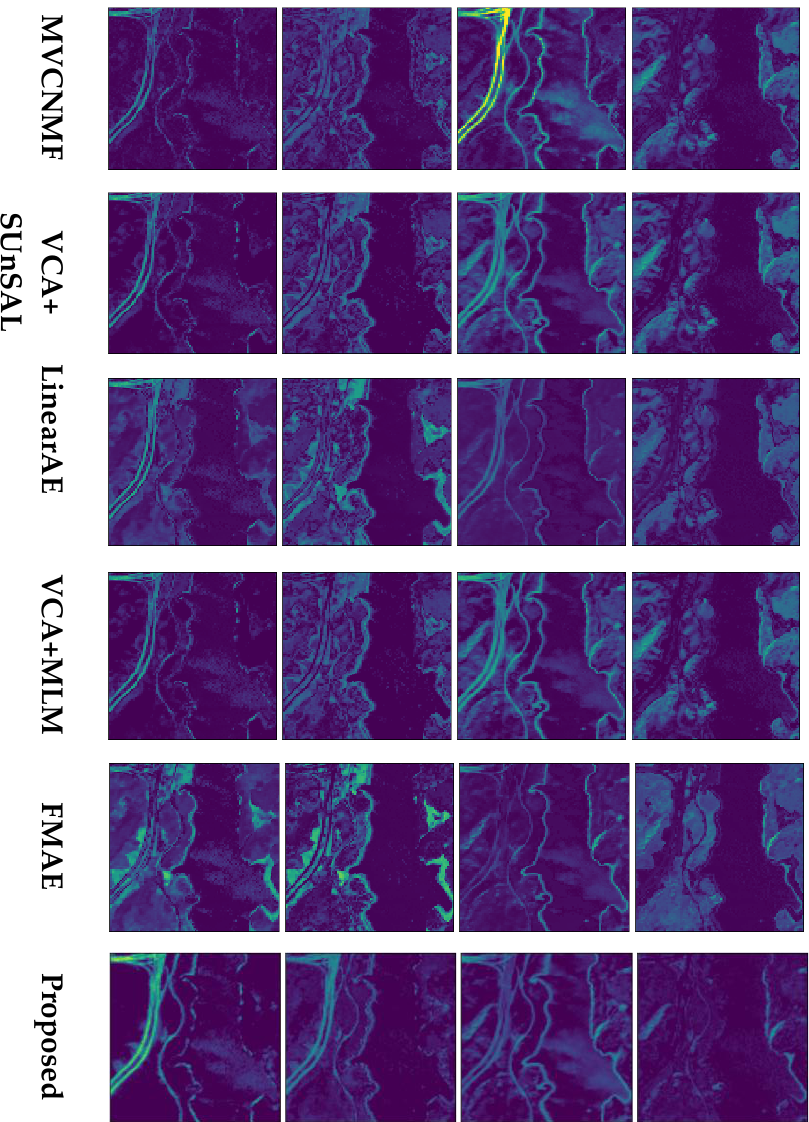
Figure 9. Estimated abundance maps for Jasper Ridge. From left to right for different endmembers: road, soil, water and tree. From top to bottom for different methods.